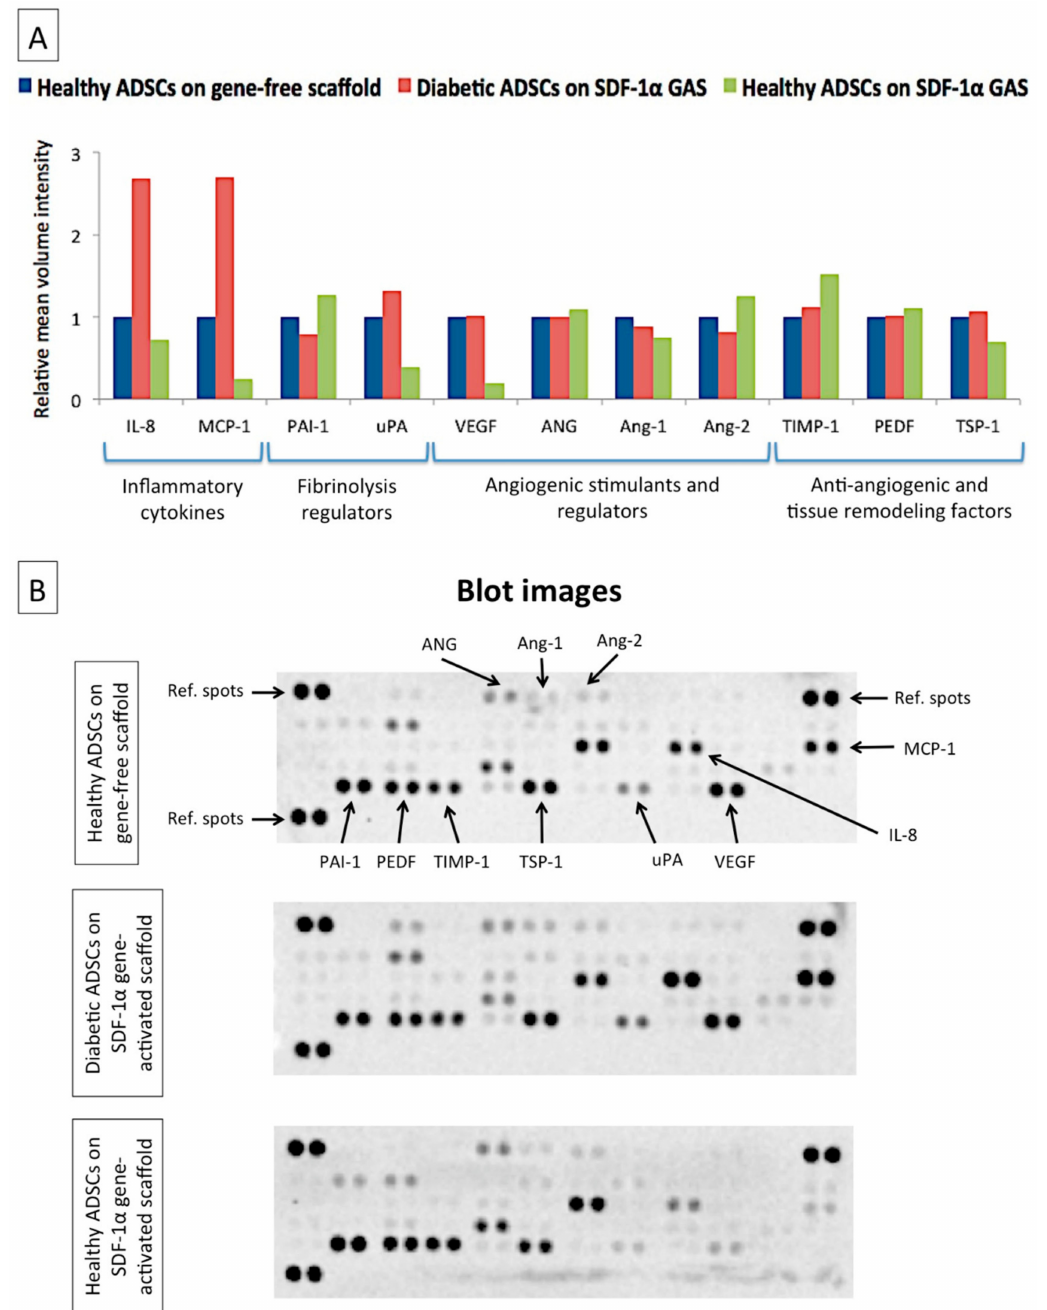
Figure 3. Impact of SDF-1 α gene-activated scaffold on the production of functional factors in healthy and diabetic ADSCs. ( A ) Transfection of the diabetic ADSCs within the SDF-1 α gene-activated scaffold resulted in restoration of a healthy-like signaling of functional factors in the diabetic ADSCs. On the other hand, the SDF-1 α gene-activated scaffold caused a mod- erate deviation in the signaling pattern of the functional factors in the healthy ADSCs relative to its unactivated equivalent. ( B ) Representative blot images of the proteome